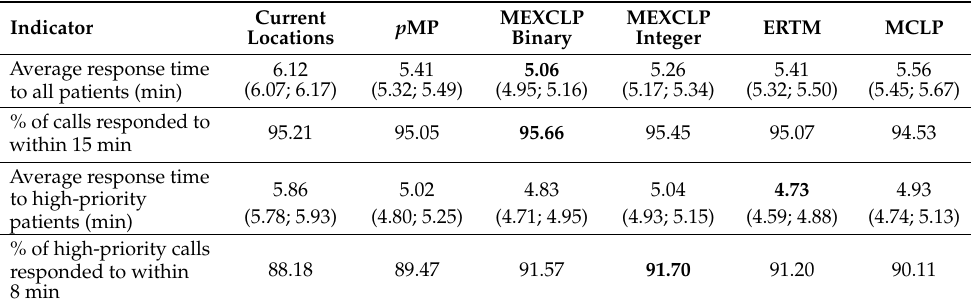
Table 5. Performance indicators for different distributions of the EMS stations in the city of Prešov, street model of